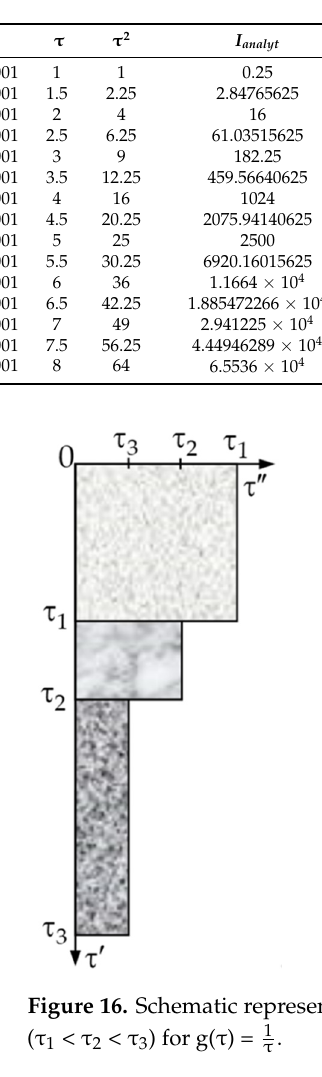
Table 16. Calculation of integral